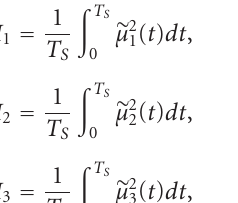
Table 3: Performance criterion results (noisy measurements). Tuning